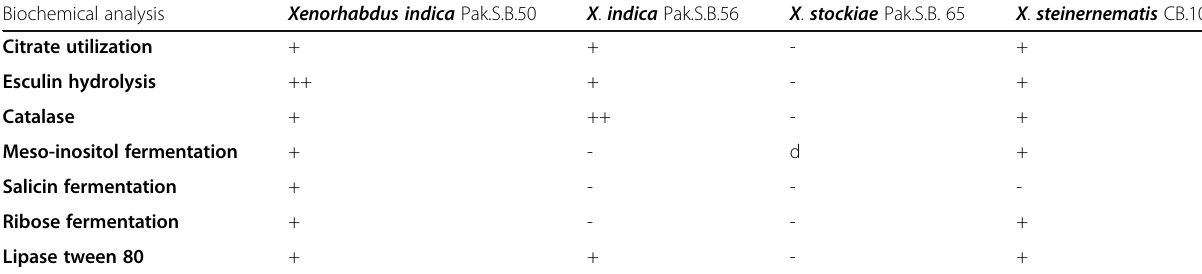
Table 2 Biochemical analysis of symbiotic